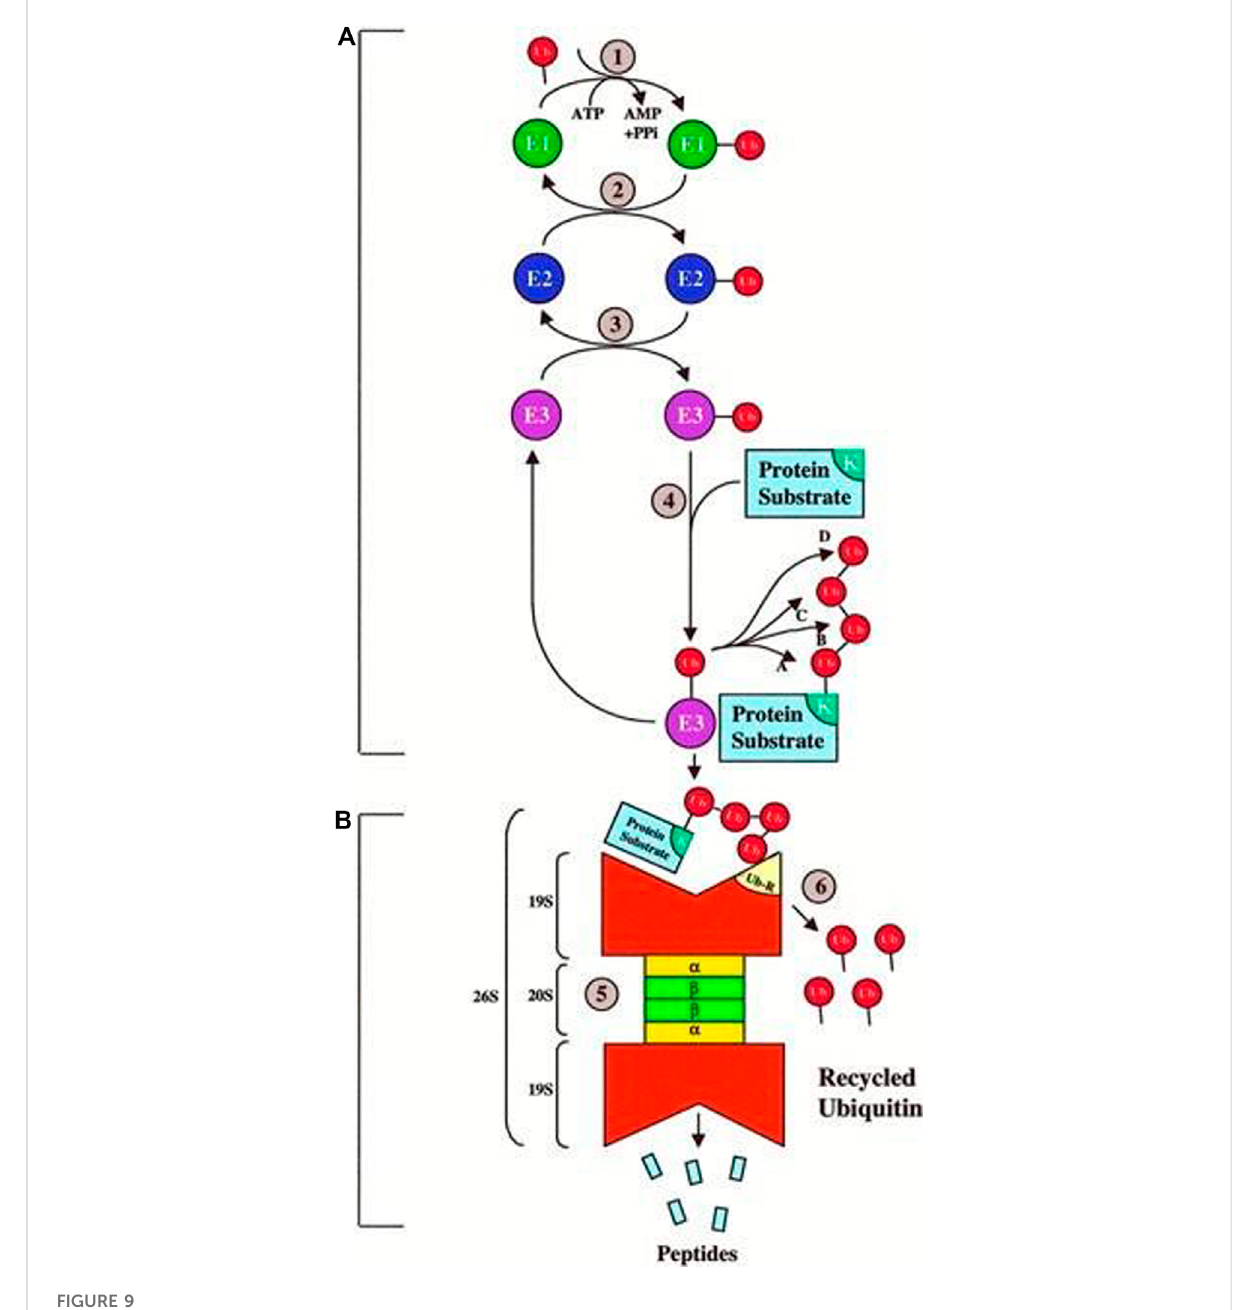
FIGURE 9 Ubiquitin – proteasome pathway (Ciechanover,